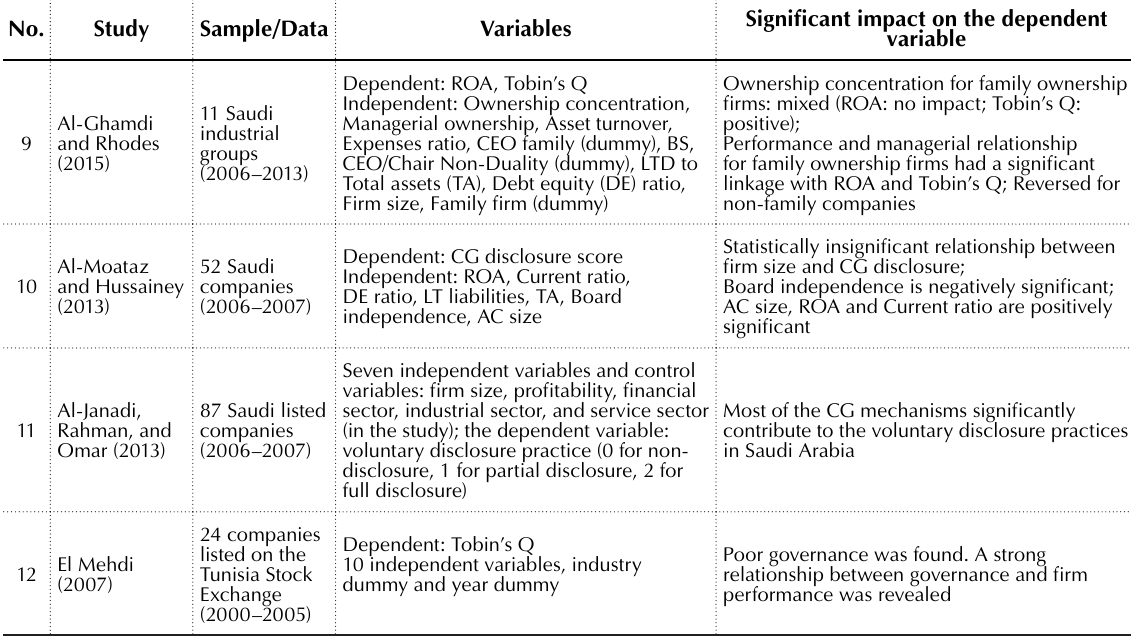
Table 1 (cont.). Summary of the literature review